Question: Summarize what this figure shows in one sentence.
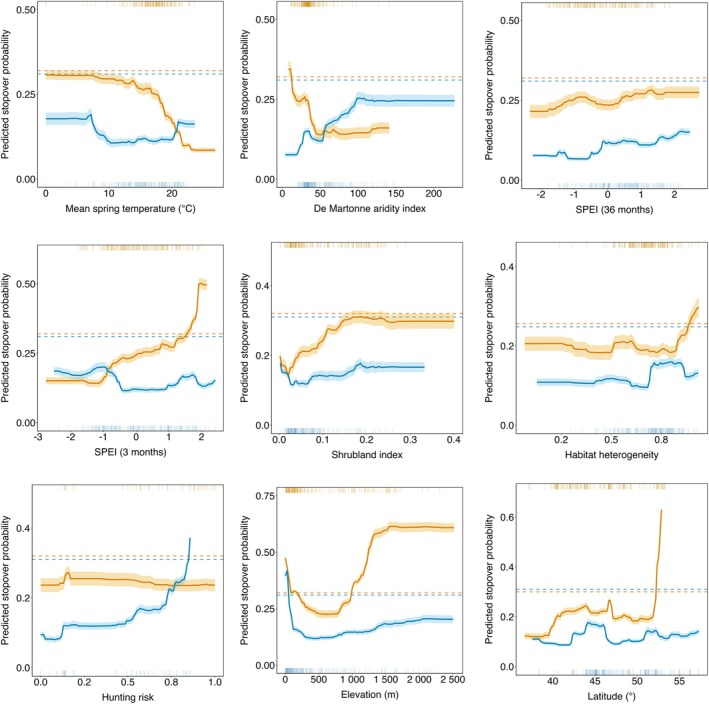
Answer: Response curves (with 95% confidence intervals) for the eastern ( blue ) and western ( orange ) ensemble models, with latitude included as a predictor. Included are the top five environmental predictors for the eastern route (hunting risk, habitat heterogeneity, elevation, aridity and SPEI36) and western route (aridity index, elevation, spring temperature, SPEI3 and shrubland), as well as latitude. Blue and orange dashed lines indicate the mean max TSS threshold for eastern and western models, respectively. Rugs denote true stopovers.